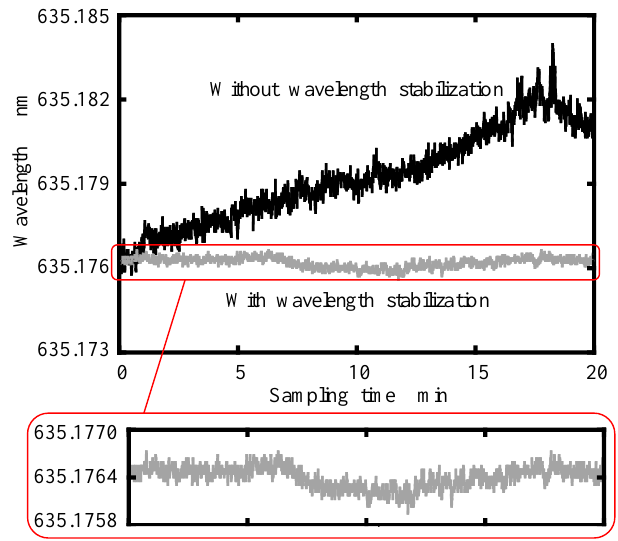
Figure 8. Real-time recording of the laser diode wavelength with and without stabilization.